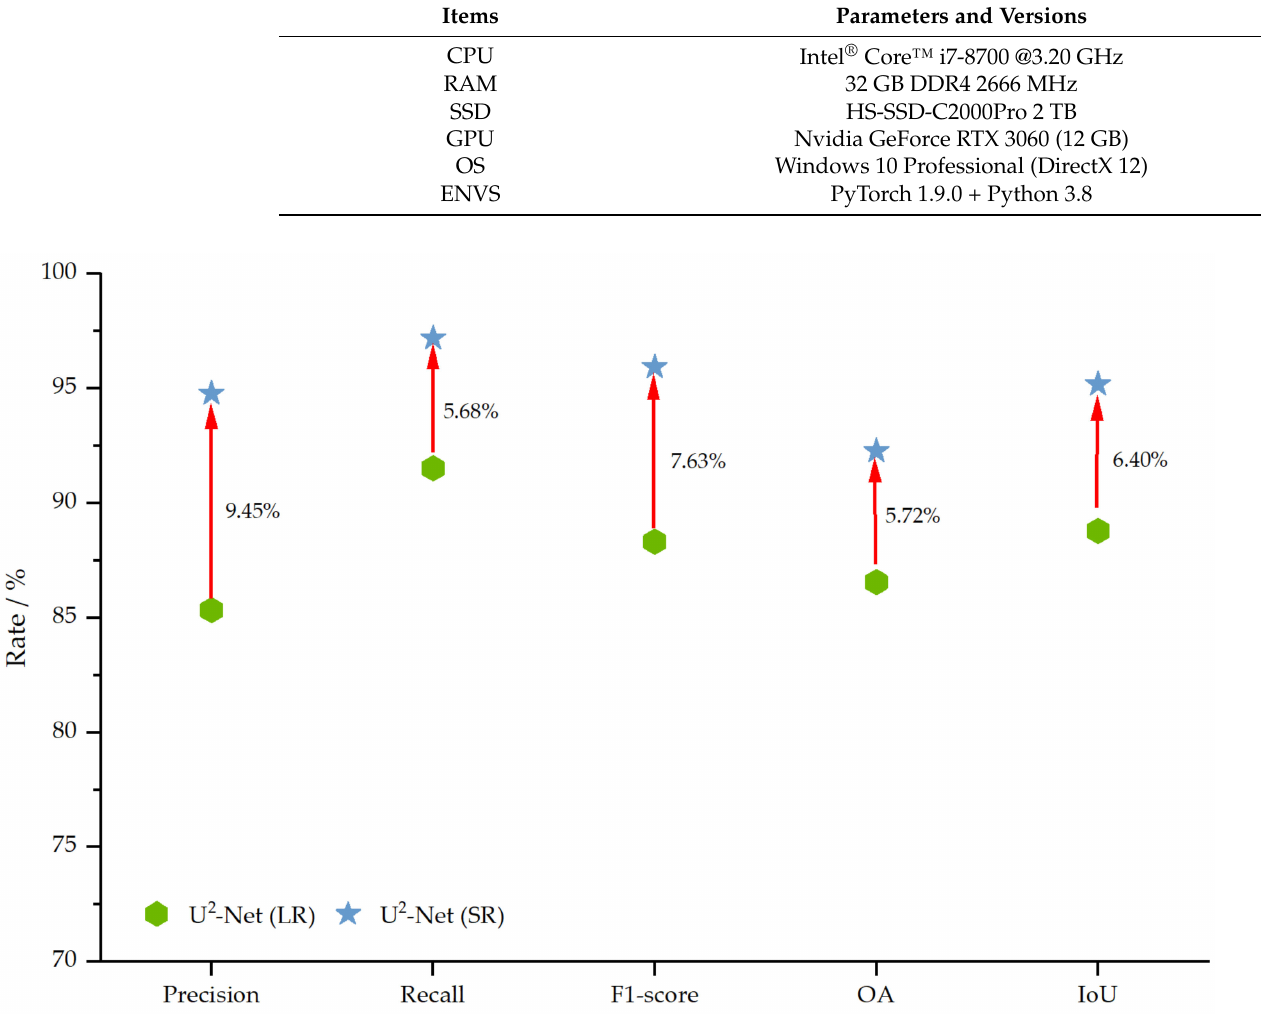
Figure 9. Comparison diagram of the performance of different resolution